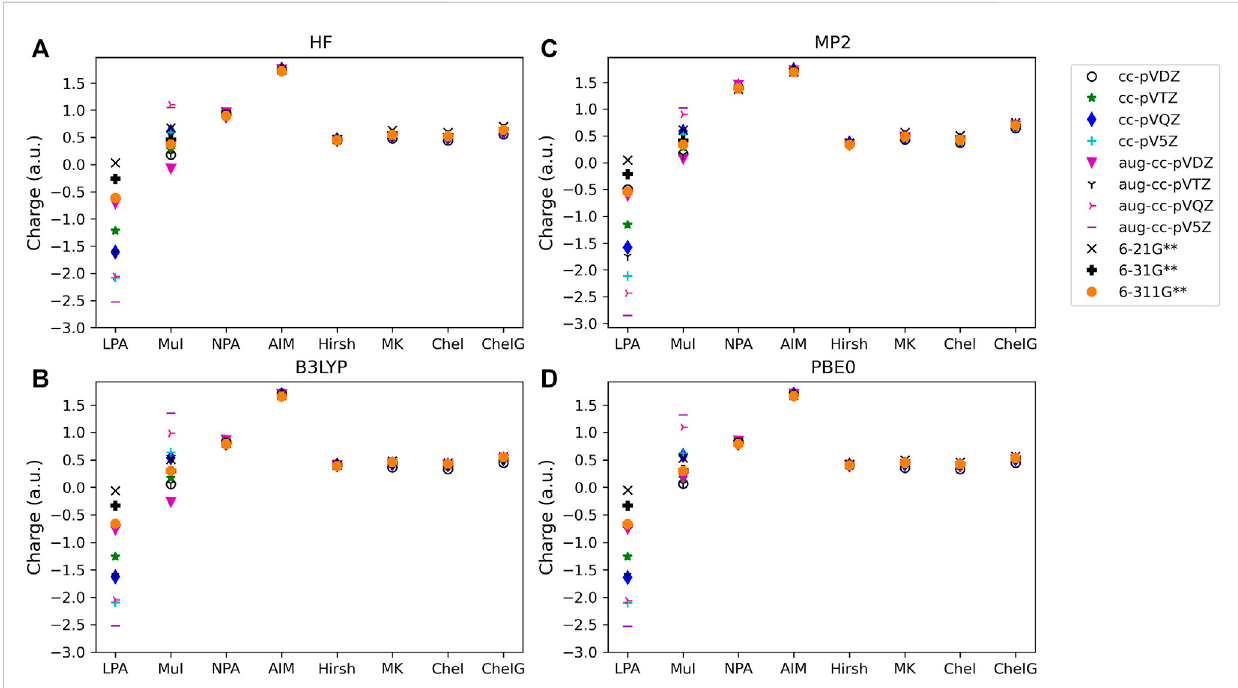
FIGURE 2 Atomic charge determined for noted basis set, analysis method and quantum mechanical method: (A) HF, (B) B3LYP, (C) MP2, and (D) PBE0 for one of the triatomic compounds investigated, BeCl2. Charges for the remaining four triatomic compounds studied are included in the SI.